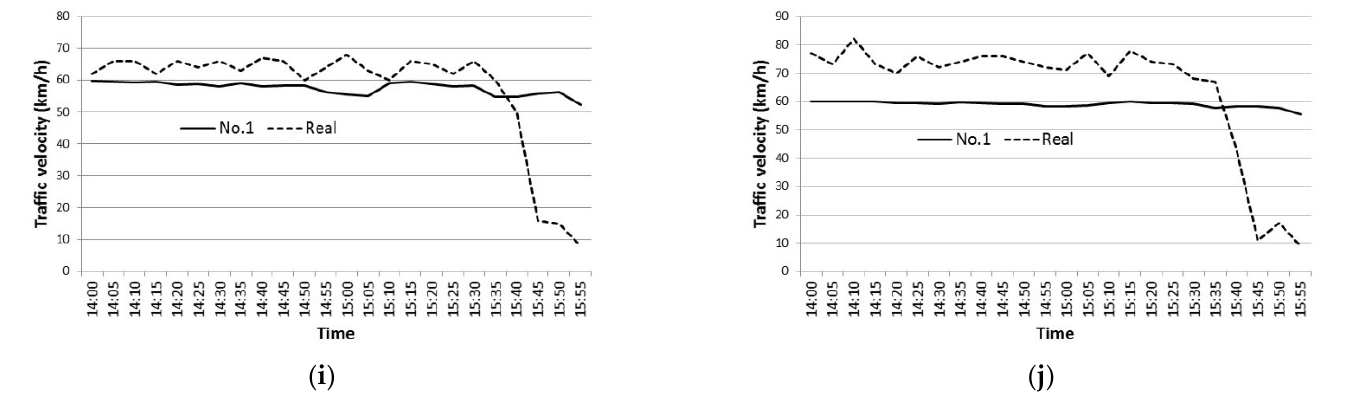
Figure 6. ( a ) Velocity in 1st lane at a-1 (no. 1); ( b ) Velocity in 2nd lane at a-2 (no. 1); ( c ) Velocity in 1st lane at b-1 (no. 1); ( d ) Velocity in 2nd lane at b-2 (no. 1); ( e ) Velocity in 1st lane at c-1 (no. 1); ( f ) Velocity in 2nd lane at c-2 (no. 1); ( g ) Velocity in 2st lane at d-2 (no. 1); ( h ) Velocity in 2nd lane at e-2 (no. 1); ( i ) Velocity in 1st lane at f-1 (no. 1); ( j ) Velocity in 2nd lane at f-2 (no. 1).